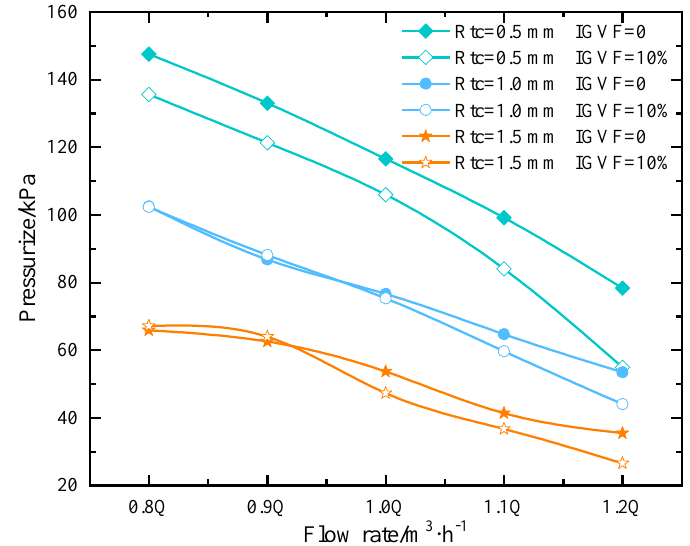
Figure 8. Multiphase pump pressurization performance.